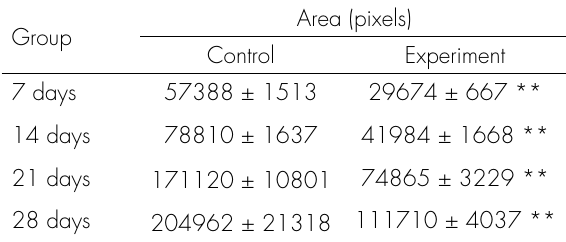
Table II. The area of resorption on the first molar root in the experimental and control groups.